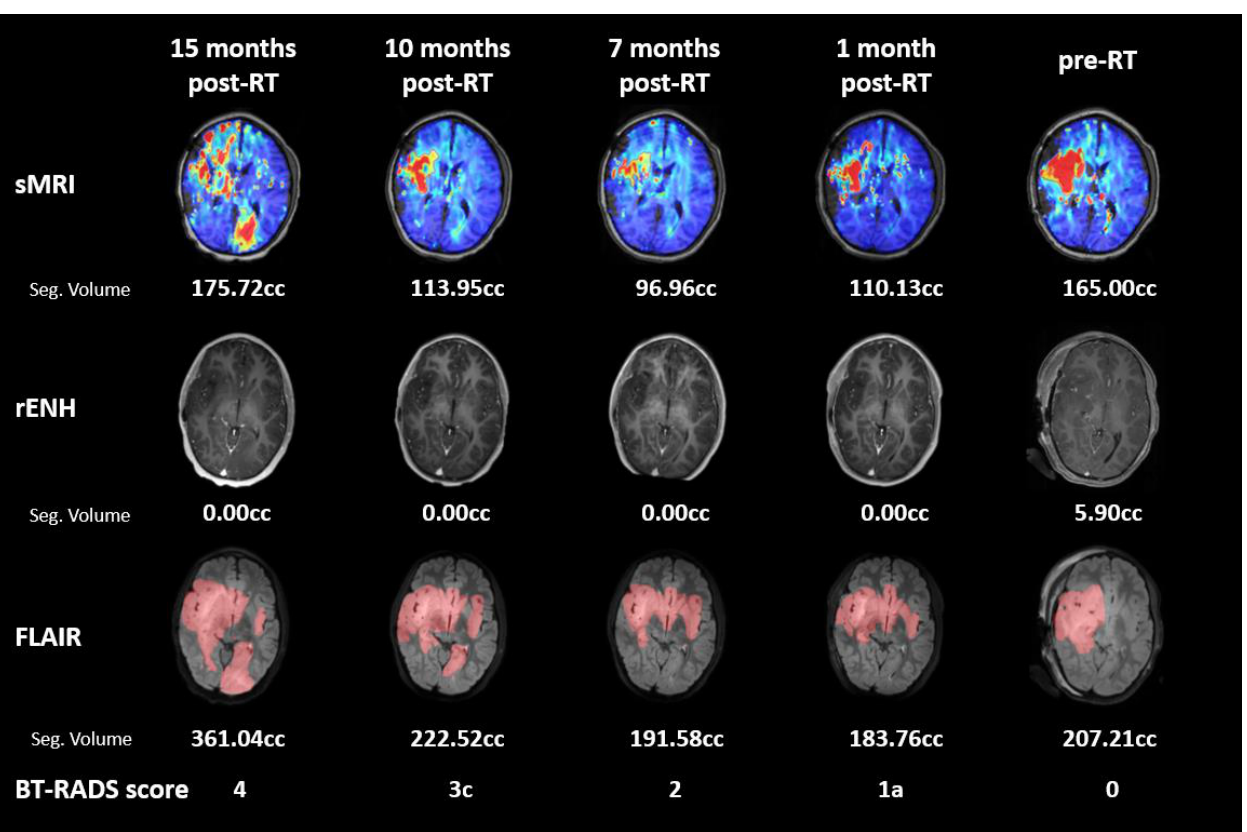
Figure 4. Subject 1 longitudinal follow-up imaging shown in BrICS-LIT. Five follow-up images and their corresponding sMRI, T1w-CE, and T2 FLAIR are shown chronologically from right to left, with the pre-RT treatment planning image first. Lesion volumes have been segmented, and each follow-up is scored by a neuroradiologist. No contrast enhancing tumor was seen in follow-ups. The imaging shows a positive response to treatment with decreasing volumes on sMRI from pre-RT to 7 months post-RT; the FLAIR volumes decreased and remained stable during this time period. Beginning at 10 months post-RT both sMRI and FLAIR volumes began to increase, with a greater than 25% volumetric increase from 10 months to 15 months post-RT. An out-of-field metabolically active mass is present on the 15 months post-RT sMRI in the left occipital lobe.